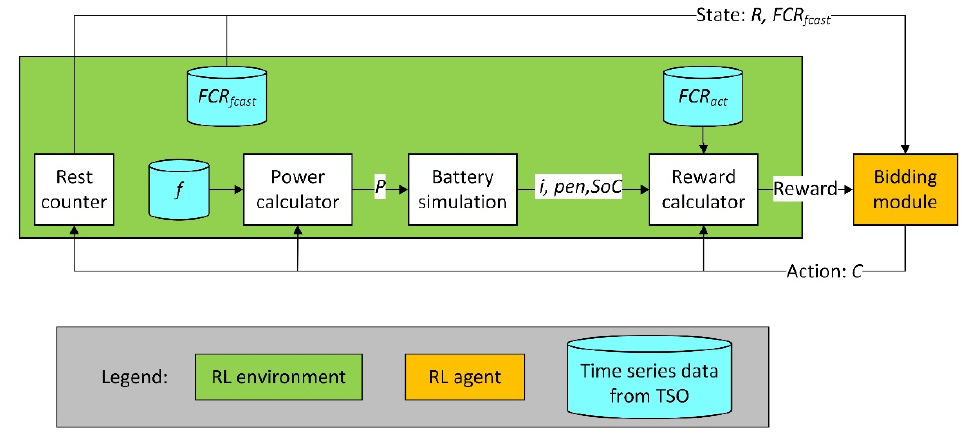
Figure 1. Architecture for training the RL agent.